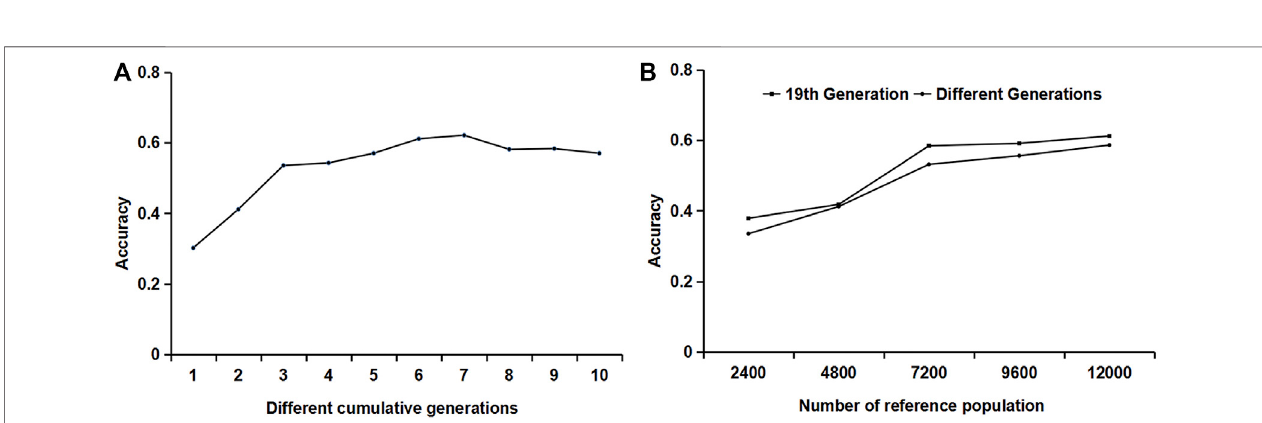
FIGURE 4 | The in fl uence of different generations and different relationships of the reference populations on accuracy. (A) The in fl uence of reference populations from different generations on accuracy. (B) The in fl uence of the relationship between reference individuals on accuracy.